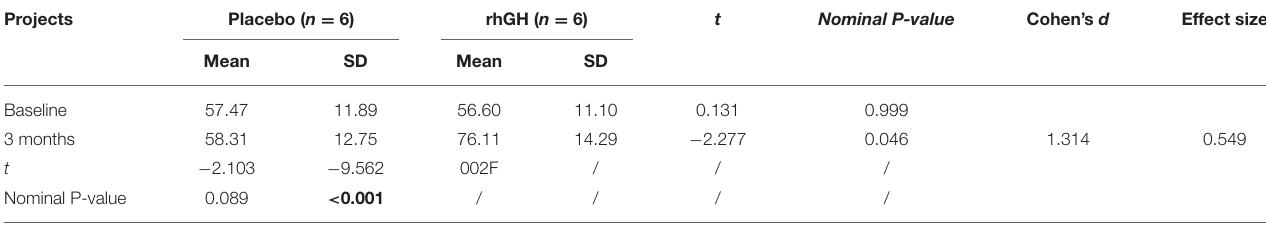
TABLE 4 | Comparison of the total scores of the GDS before and after treatment.